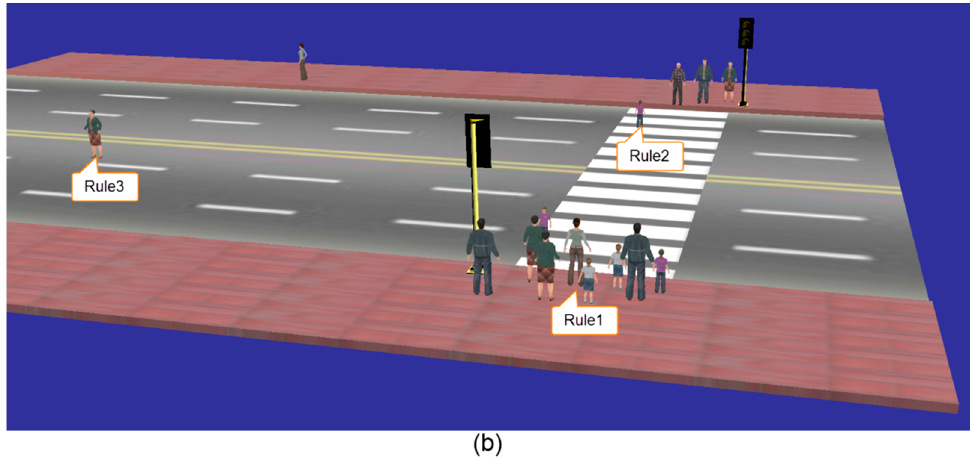
Figure 10. The 3D scene of individual behavior simulation for case 2. The time interval between ( a ) and ( b ) was 5 s, and the traffic lights in ( a , b ) are both red.